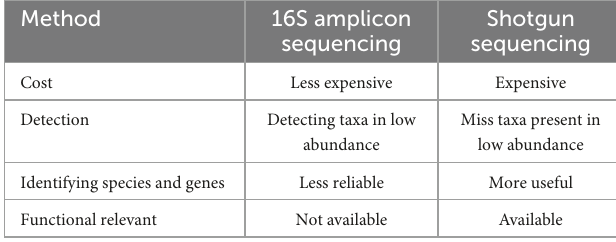
TABLE 1 Commonly used methods to assess the microbiota.